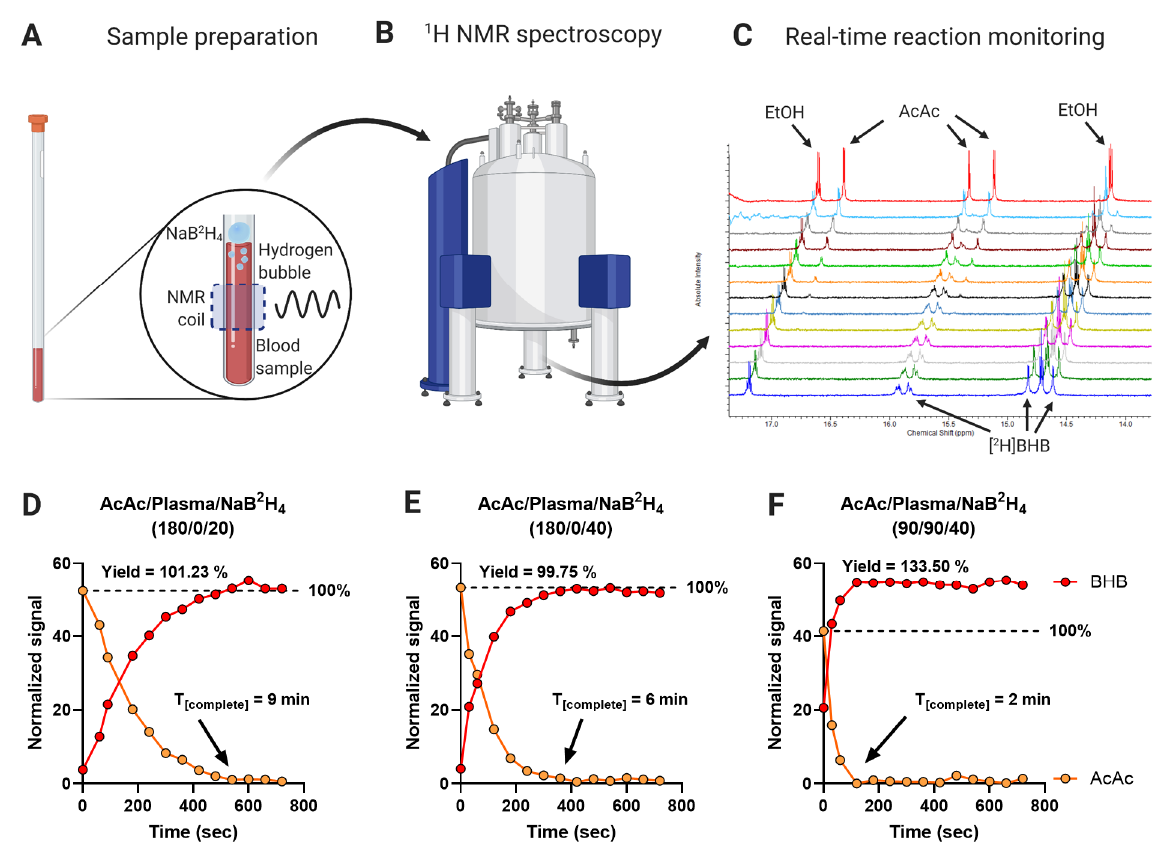
Figure 5. Evaluation of AcAc conversion to [ 2 H]BHB by real-time reaction monitoring. ( A ) Sample preparation—reaction of NaB 2 H 4 with water caused the release of hydrogen resulting in bubbles and poor magnetic field homogeneity. This was prevented by the addition of NaB 2 H 4 to the surface of the reaction solution, allowing acquisition of NMR spectra. ( B ) The sample was immediately loaded into the NMR spectrometer and ( C ) 1 H NMR spectra were recorded every 60 s to capture the evolution of BHB resonances over time. ( D – F ) Integrated and normalized BHB and AcAc signals over time. A standard sample of 180 µ L of AcAc solution was mixed with either ( D ) 20 µ L of NaB 2 H 4 or ( E ) 40 µ L of NaB 2 H 4 . ( F ) 90 µ L of a mouse plasma sample was mixed with 90 µ L of a AcAc solution and topped with 40 µ L of NaB 2 H 4 . The concentrations of individual solutions are described in the Materials and Methods section. Signals were normalized to total signal area.